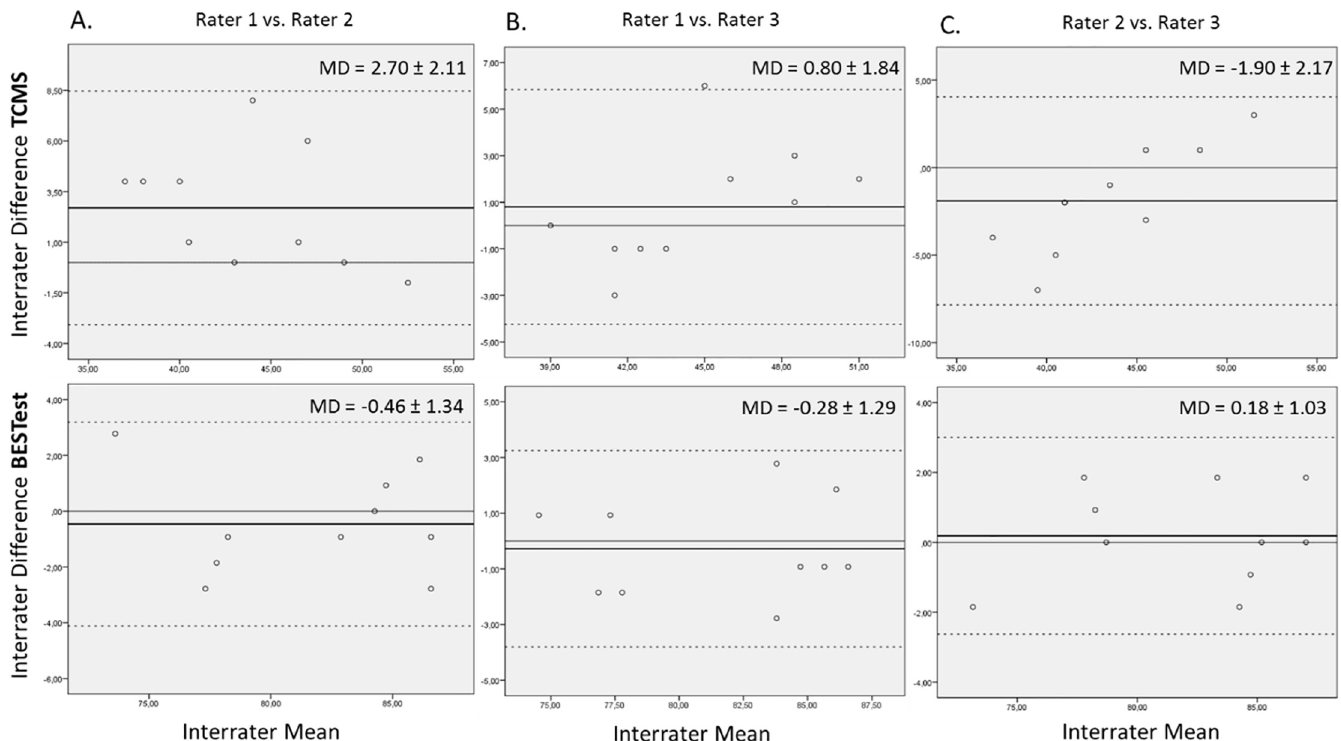
Fig 2. Bland-Altman plots for interrater reliability of TCMS and BESTest. On the horizontal axis the interrater mean score on TCMS and BESTest is displayed. On the vertical axis the difference between the total scores of the raters is plotted. The solid thin line represents the zero axis. The bold black line represents the mean difference. The dotted lines indicate the limits of agreement. MD: Mean